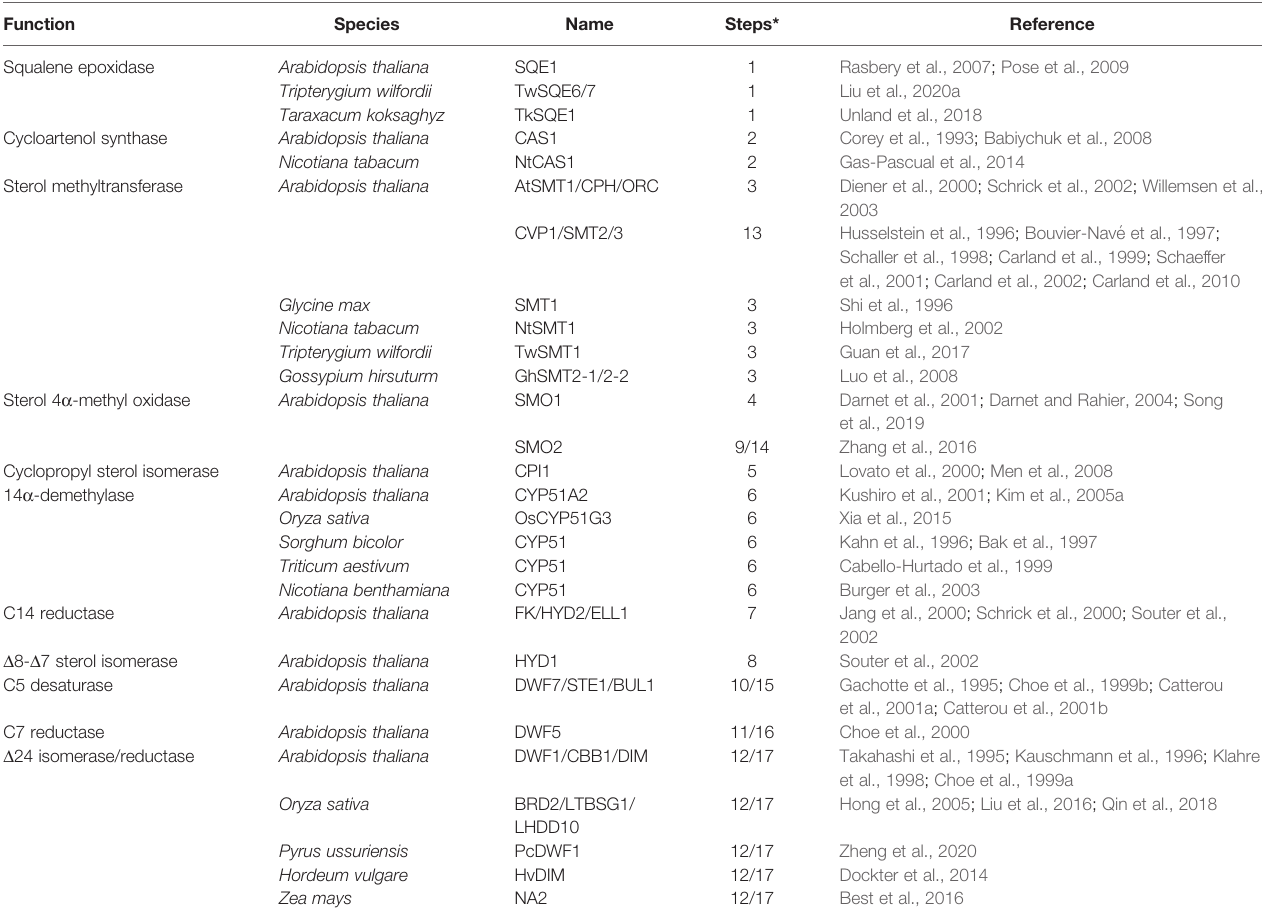
TABLE 1 | Sterol biosynthesis enzymes identi fi ed in different plant species.